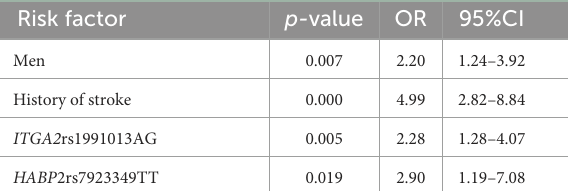
TABLE 6 Multivariate analysis of the major risk factors for moderate to severe carotid